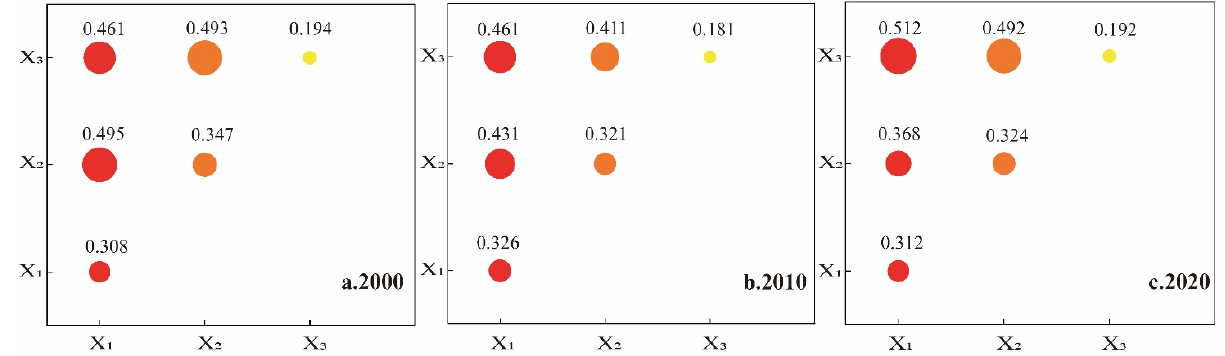
Figure 9. Detection results for the impact of the interaction of urbanization subsystems on ecosystem health, 2000–2020.